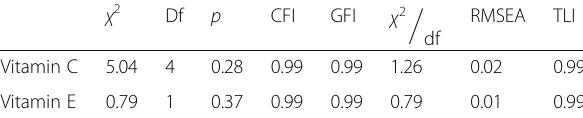
Table 2 Goodness of fit indices for the vitamin E and C consumption behavior models testing